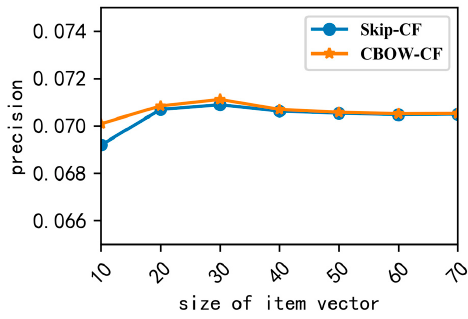
Figure 5. Precision with different vector dimension. CF: collaborative filtering.